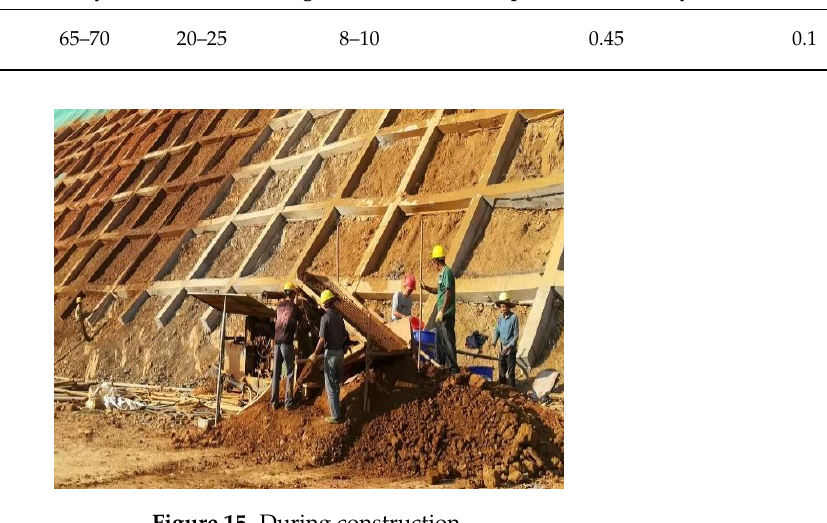
Figure 15. During construction.